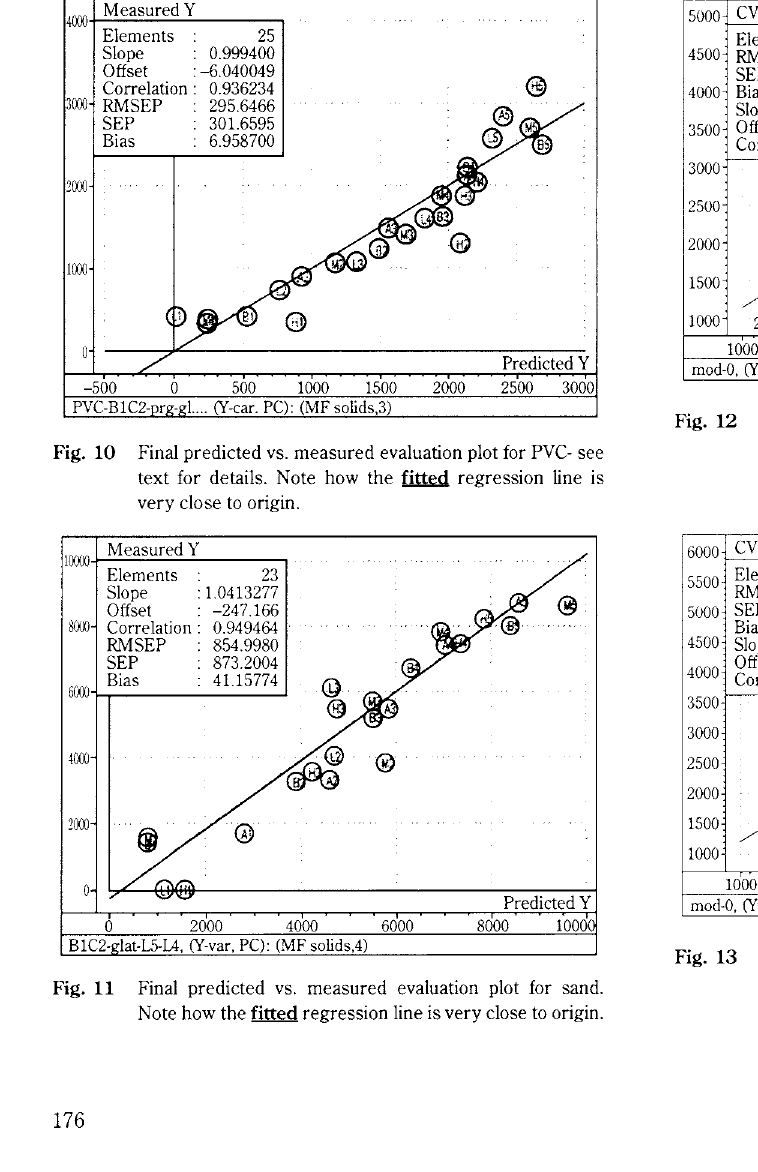
Fig. 13 Predicted vs. measured evaluation for microdol